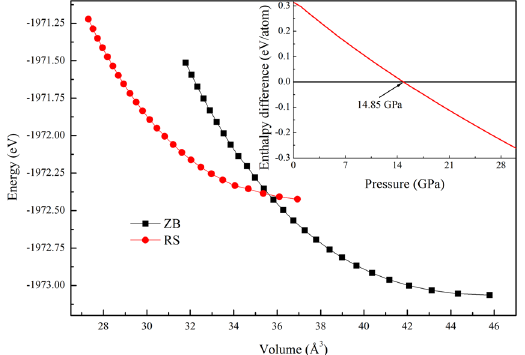
Figure 1. Total energy versus unit cell volume for the B3 and B1 phases of ZnSe. Inset: enthalpy difference as a function of pressure for ZnSe at T = 0 K.